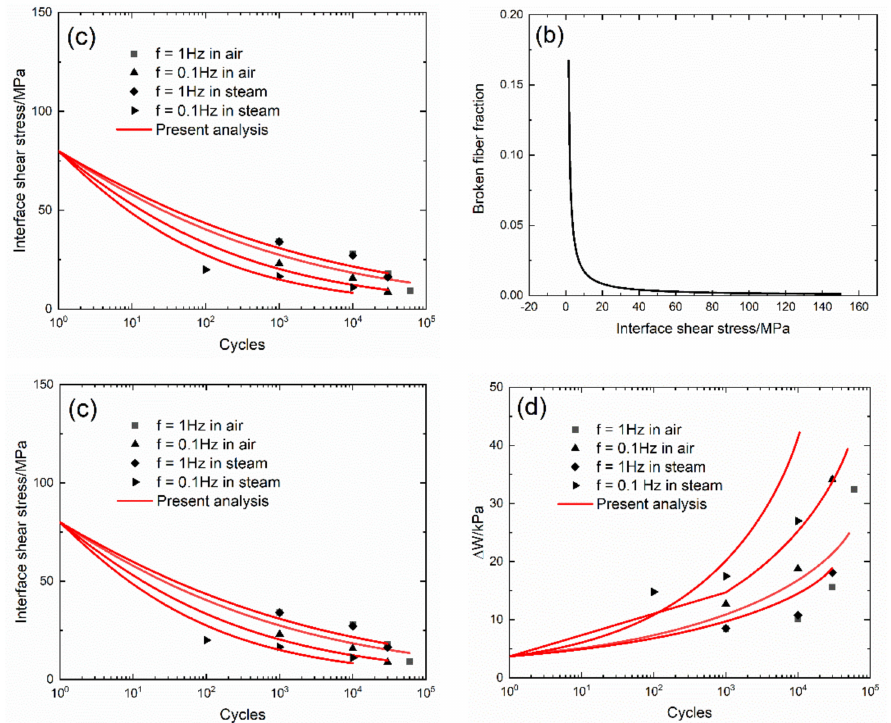
Figure 10. ( a ) Experimental and predicted dissipated energy ( ∆ W) versus the interface shear stress curves: ( b ) the broken fiber fraction (P) versus the interface shear stress curves; ( c ) the experimental and predicted interface shear stress ( τ i ) versus cycle number curves; and ( d ) the experimental and predicted dissipated energy ( ∆ W) versus cycle number curves of 2D woven self-healing Hi-Nicalon TM SiC / [SiC-B 4 C] composite at 1200 ◦ C in an air